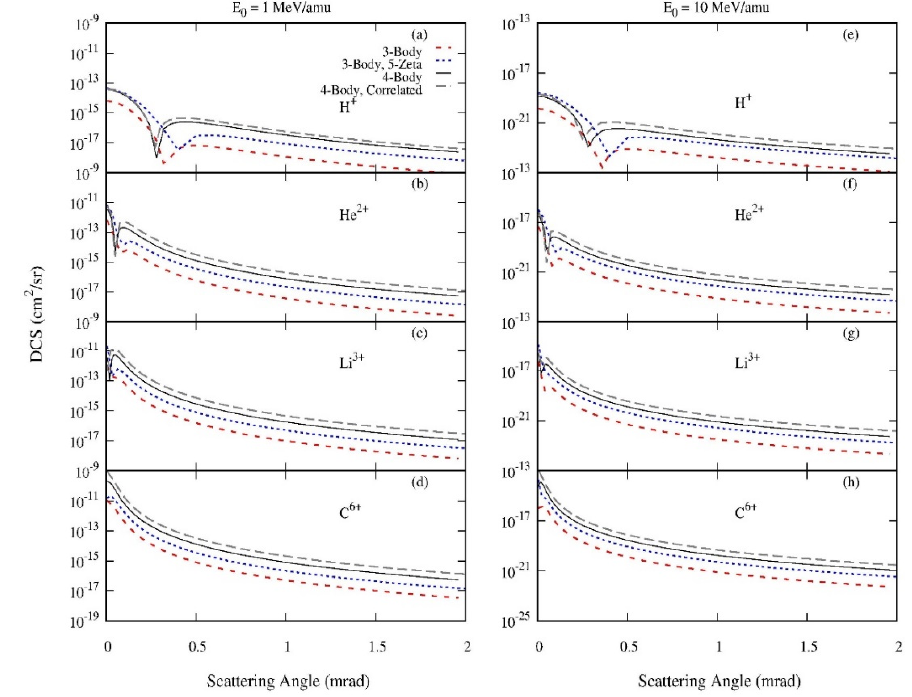
Figure 1. Di ff erential cross sections for single electron capture to the ground state with the residual He +